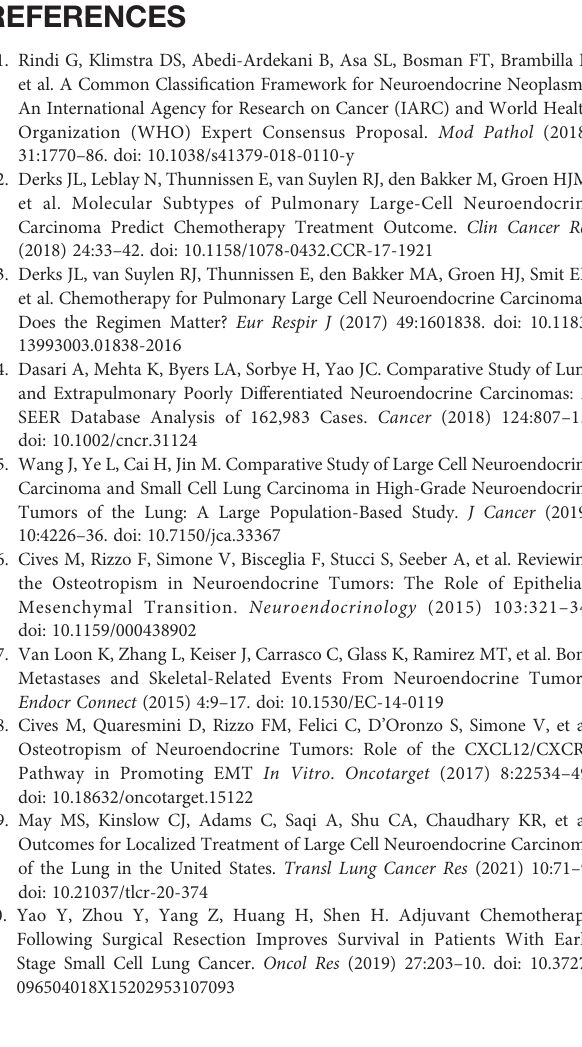
Supplementary Figure 3 | Box plot of the associations between EMT gene expression and lymph node metastasis (absence vs presence) in a log scale. The top and bottom of the box plot represents the 25th and 75th percentile range. The line across the box shows the median of gene expression and the top and bottom bars show the maximum and minimum values, outliers were showed. The association between EMT gene expression and lymph node metastasis was calculated by Fisher ’ s exact test. (A) BMP7 mRNA (P=0.005); (B) CALD1 mRNA (P=0.020); (C) CDH1 mRNA (P=0.001); (D) COL3A1 mRNA (P=0.020);